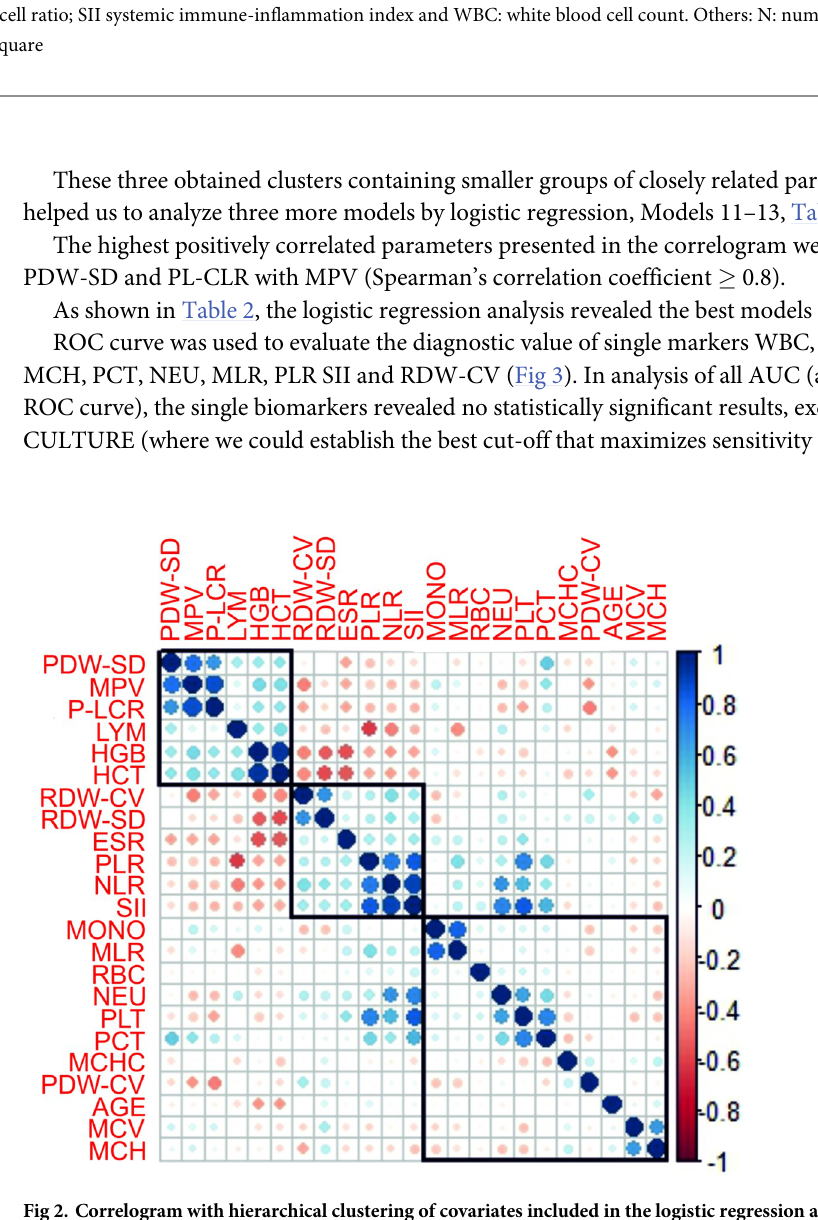
Fig 2. Correlogram with hierarchical clustering of covariates included in the logistic regression analysis. Positive and negative correlations are represented by blue and red dots. The sizes and the shades of the dots reflect the strengths of correlation between pairs of hematological parameters. Colours range from bright blue (strong positive correlation; i.e. r = 1.0) to bright red (strong negative correlation; i.e. r = − 1.0). Correlations are ordered by hierarchical clustering with clusters outline. Figure drawn using the R corrplot package (https://github.com/taiyun/corrplot).